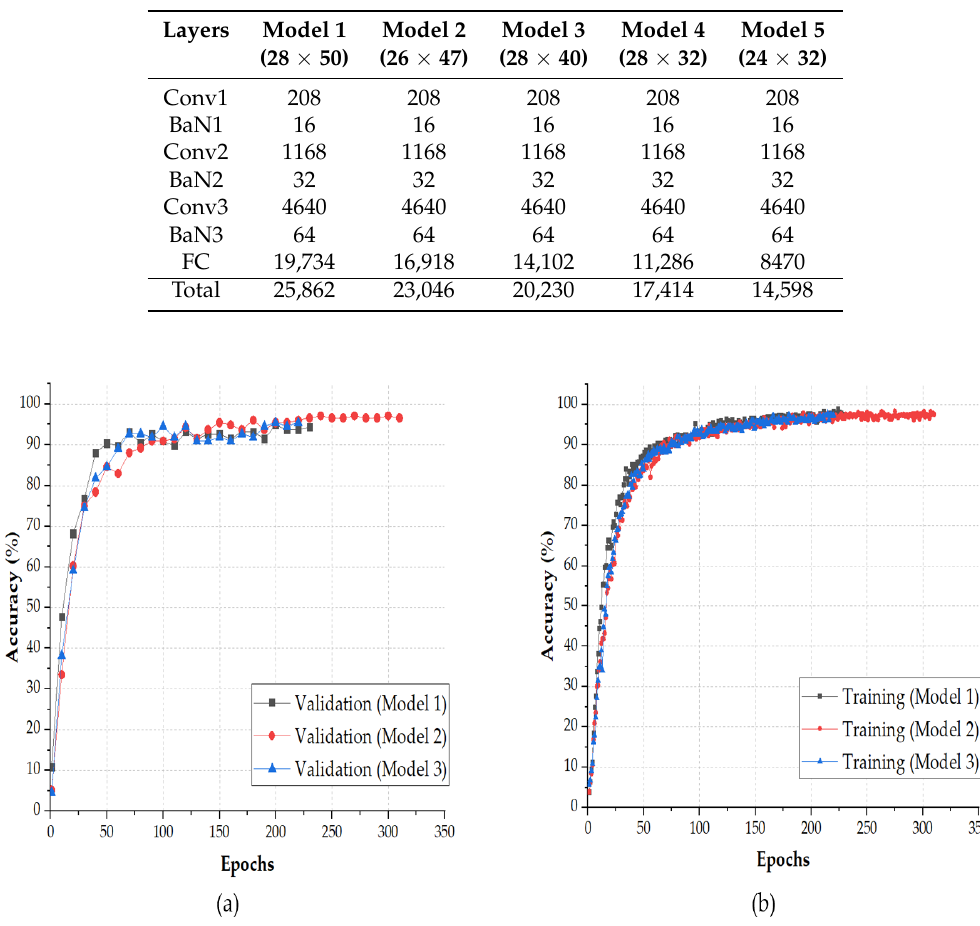
Table 1. Distribution of the number of parameters on the models’ layers.